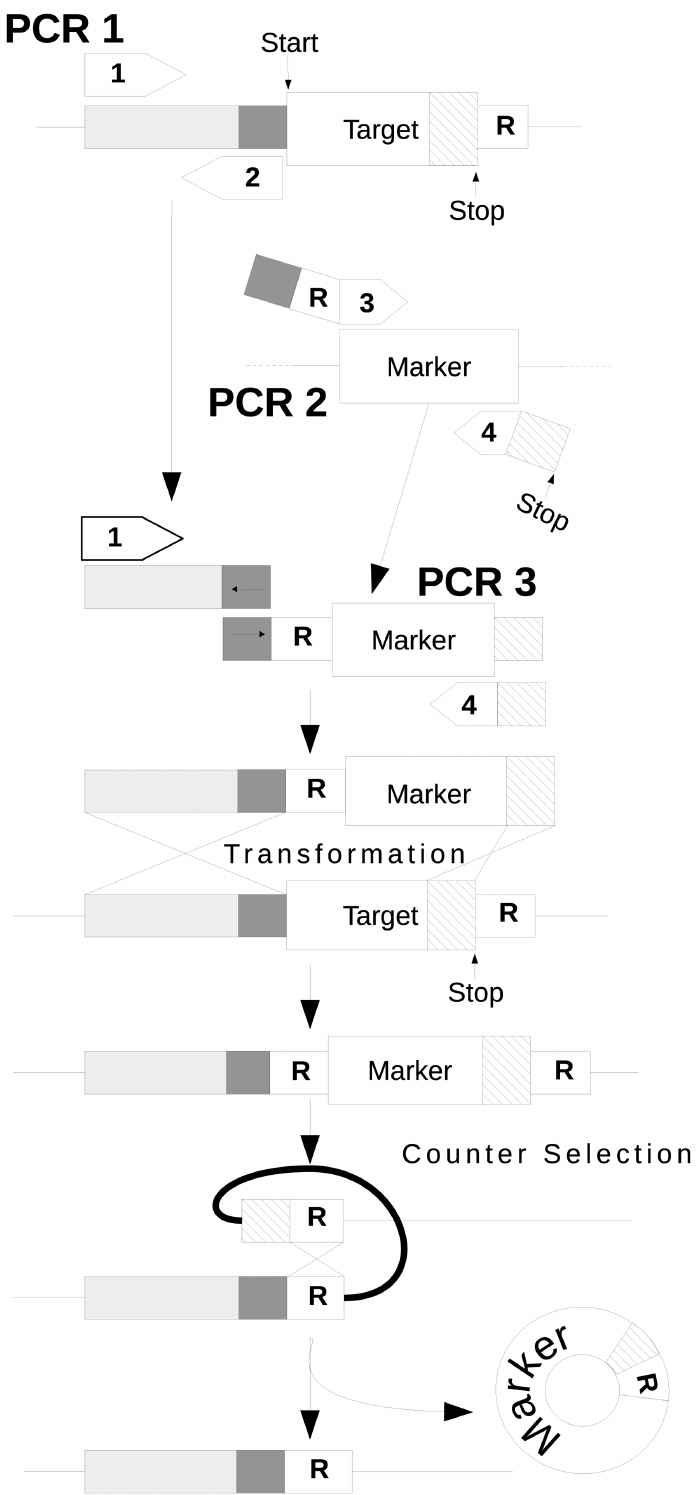
Fig 1. The seamless gene deletion method. Three PCR amplifications use two sets of primers that have complex dependencies. The PCR1 primers (1 and 2) are chosen so that the amplicon generated is a 500 – 1000 bp segment immediately adjacent to and upstream from the target gene. PCR2 generates target